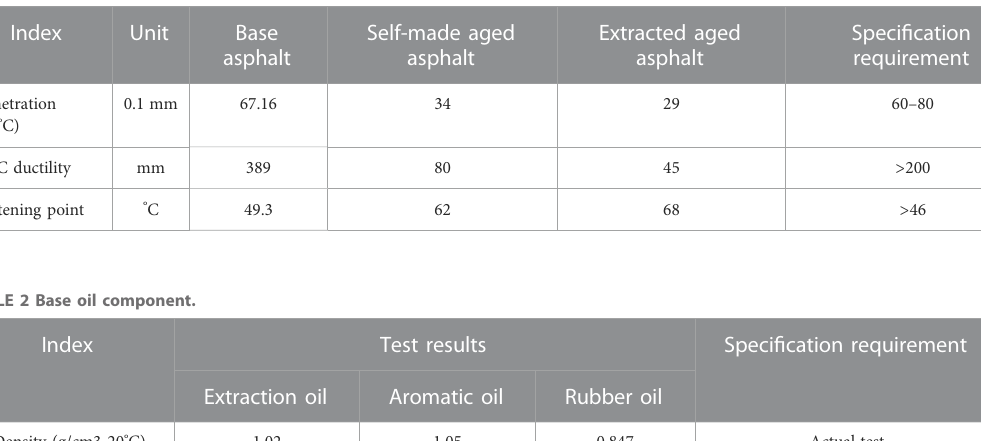
TABLE 1 Basic performances of the three kinds of asphalt.